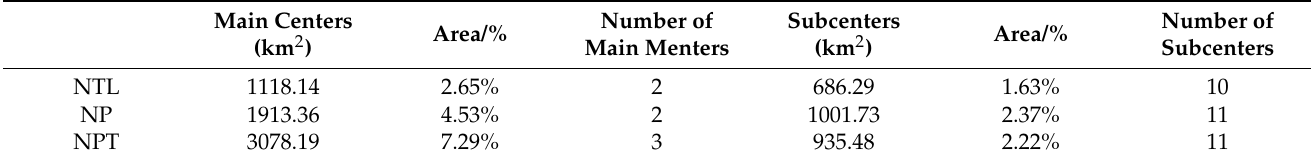
Table 2. Comparison of main centers and